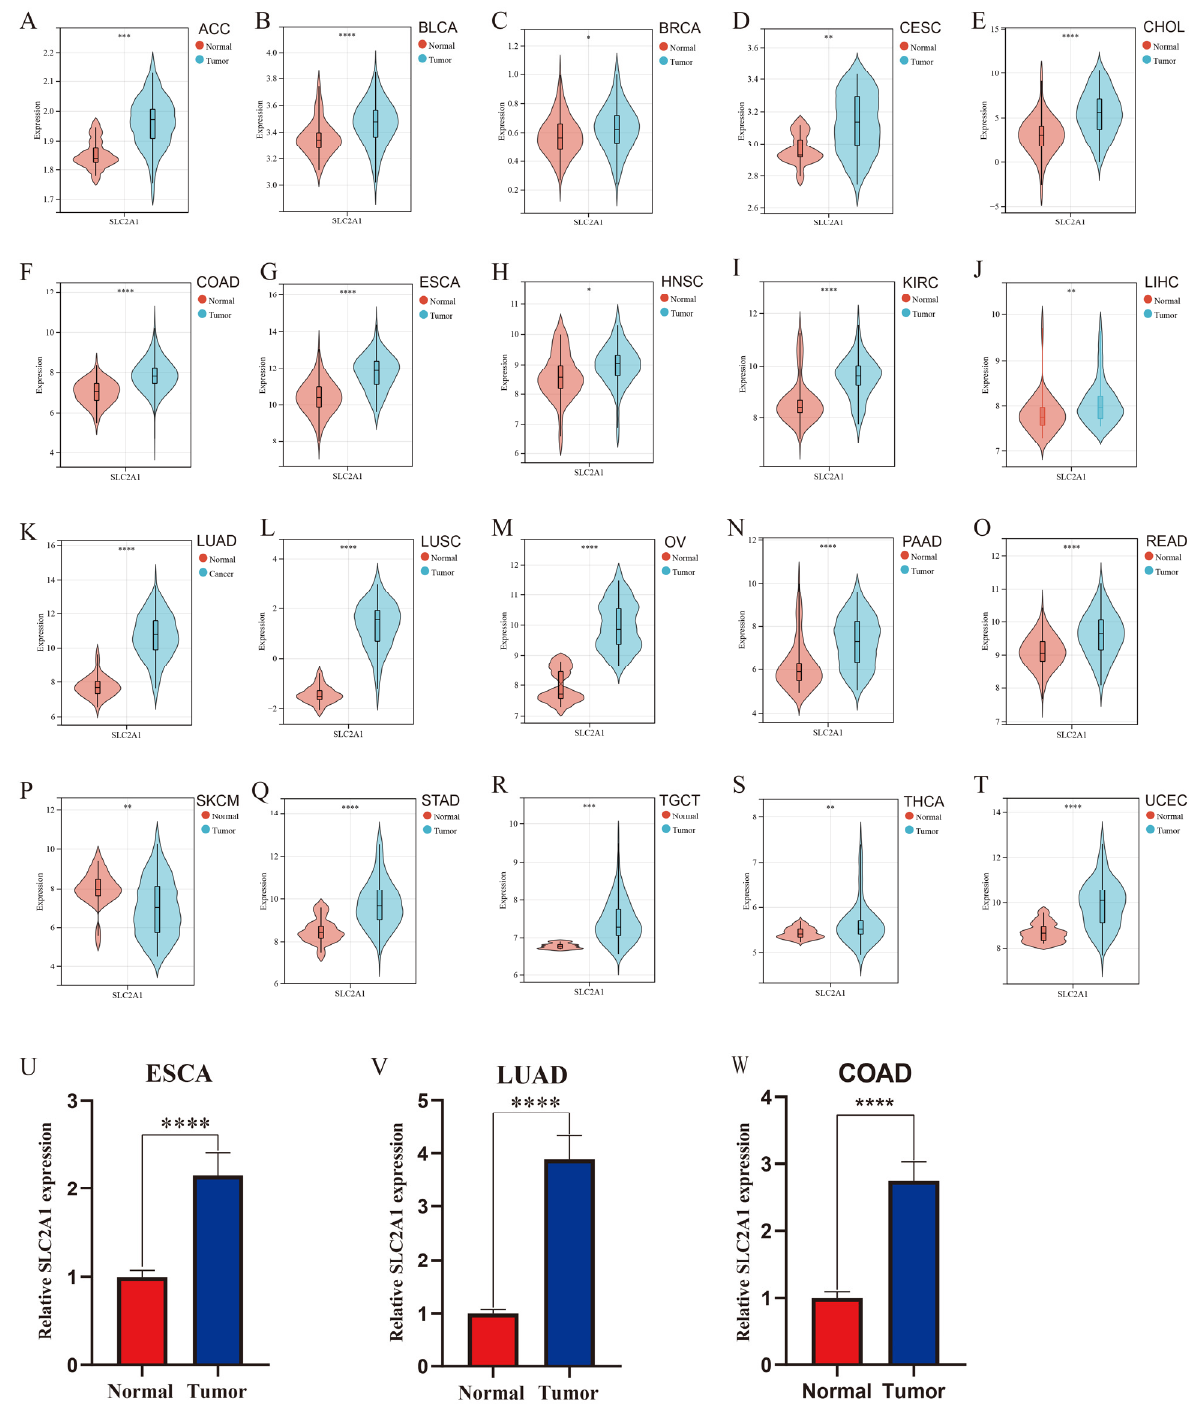
Figure 2. Validation of expression of SLC2A1 in pan-cancer. We used 20 GEO datasets for validation ( A – T ); SLC2A1 expression in 30 pairs of ESCA tissues and their normal counterparts was measured by qPCR ( U ); SLC2A1 expression in 30 pairs of LUAD tissues and their normal counterparts was measured by qPCR ( V ); SLC2A1 expression in 30 pairs of COAD tissues and their normal counterparts was measured by qPCR ( W ) (*, p < 0.05; **, p < 0.01; ***, p < 0.001; ****, p < 0.0001).